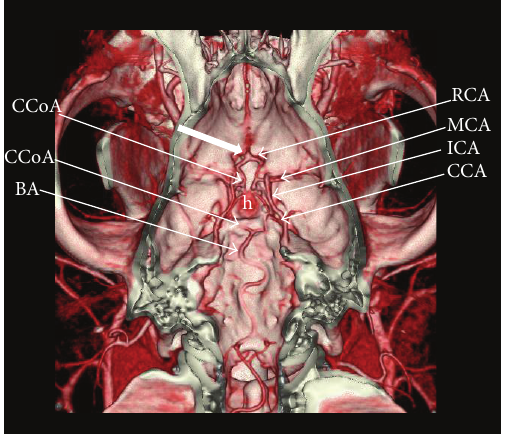
Figure 2: Volume rendering (VR) of the skull, dorsal view. The vault of the skull has been removed to visualize the circulus arteriosus cerebralis (Circle of Willis). RCA: rostral cererbal artery; MCA: middle cerebral artery; ICA: internal carotid artery; CCA: caudal cerebral artery; CCoA: caudal communicating artery; BA: basilar artery; h: hypophysis. The arrow indicates the small aneurysm at the joining point of the two rostral cerebral arteries